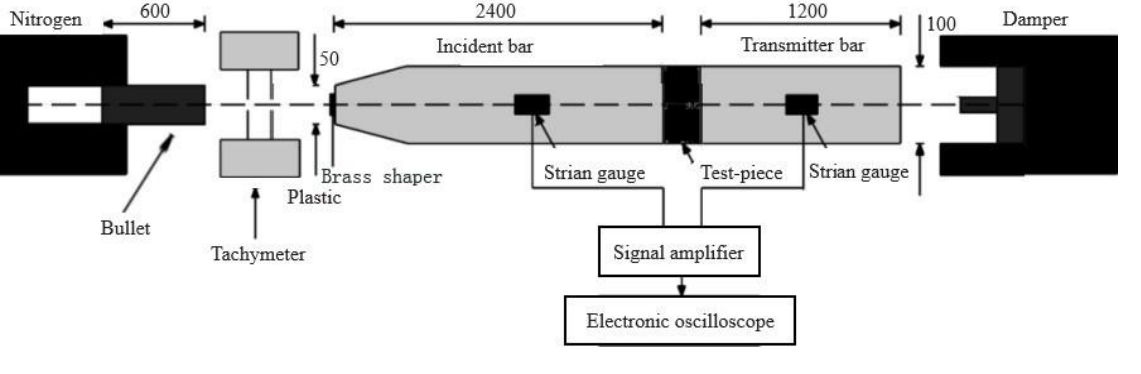
Figure 2. SHPB device.